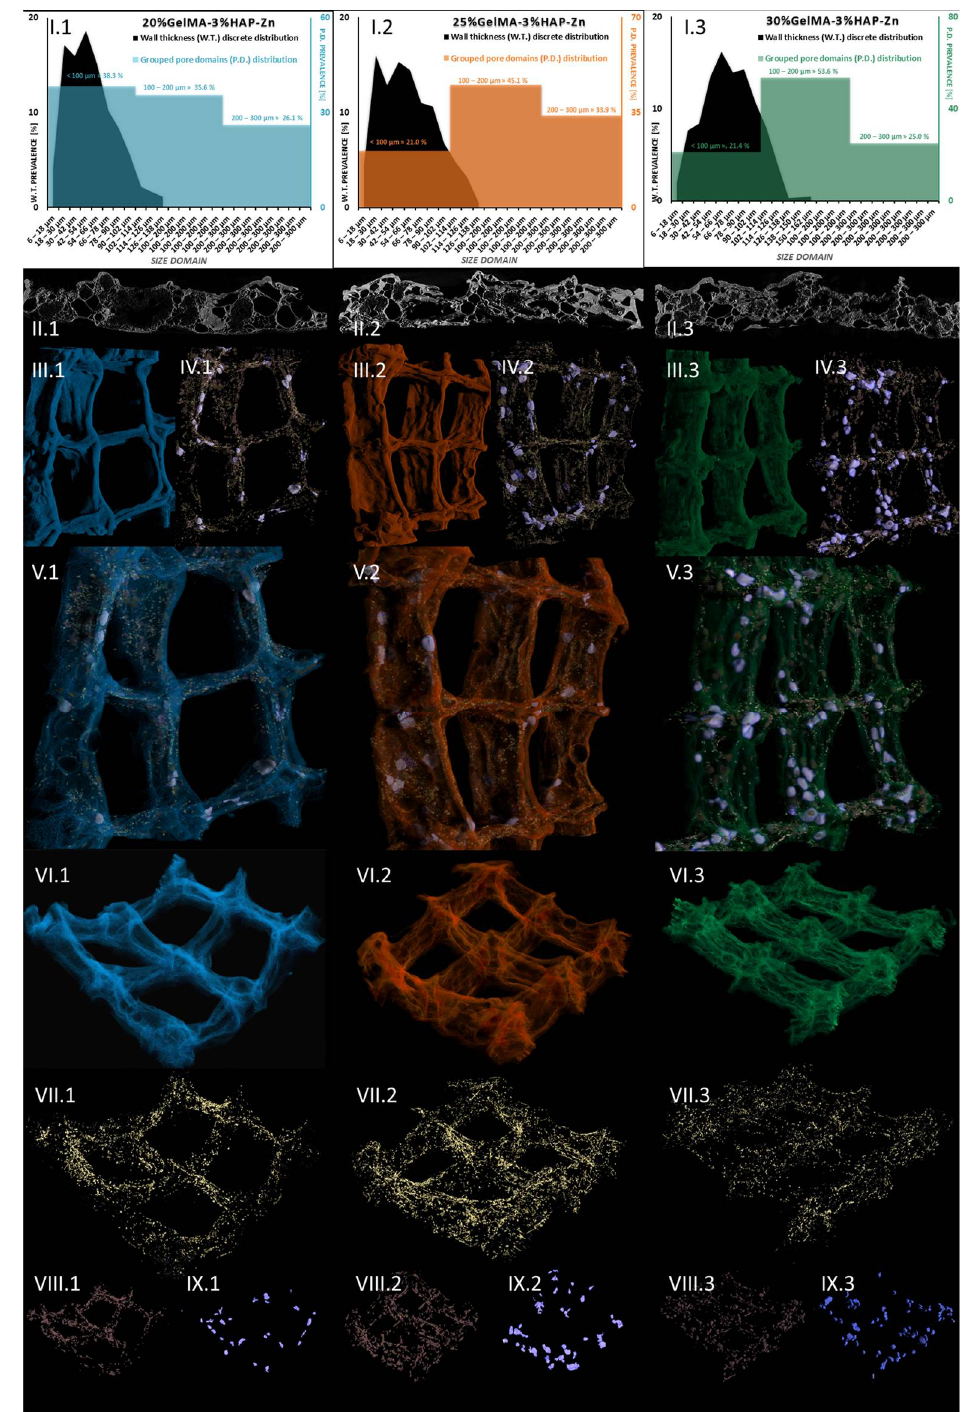
Figure 14. Micro-CT images of: (1 blue) 20%GelMA-3%HAP-Zn, (2 orange) 25%GelMA-3%HAP-Zn, and (3 green) 30%GelMA-3%HAP-Zn 3D-printed composites.